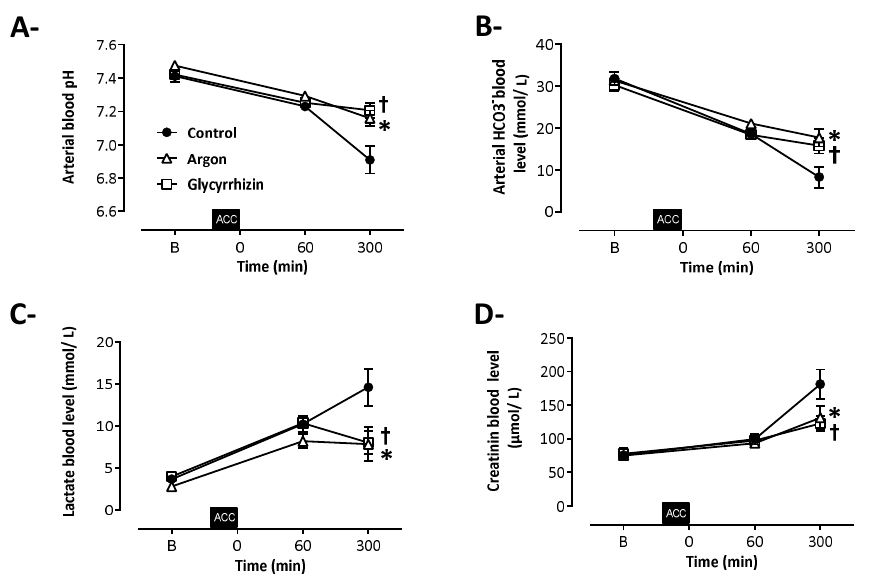
Figure 3. Arterial pH ( A ) and blood levels of HCO 3 – ( B ), arterial lactate ( C ) and plasma creatinine ( D ). ACC: Aortic cross clamping; * p < 0.05 between Control and Argon; † p < 0.05 between Control and Glycyrrhizin; Control ( n = 7), Argon ( n = 7), Glycyrrhizin ( n = 7).